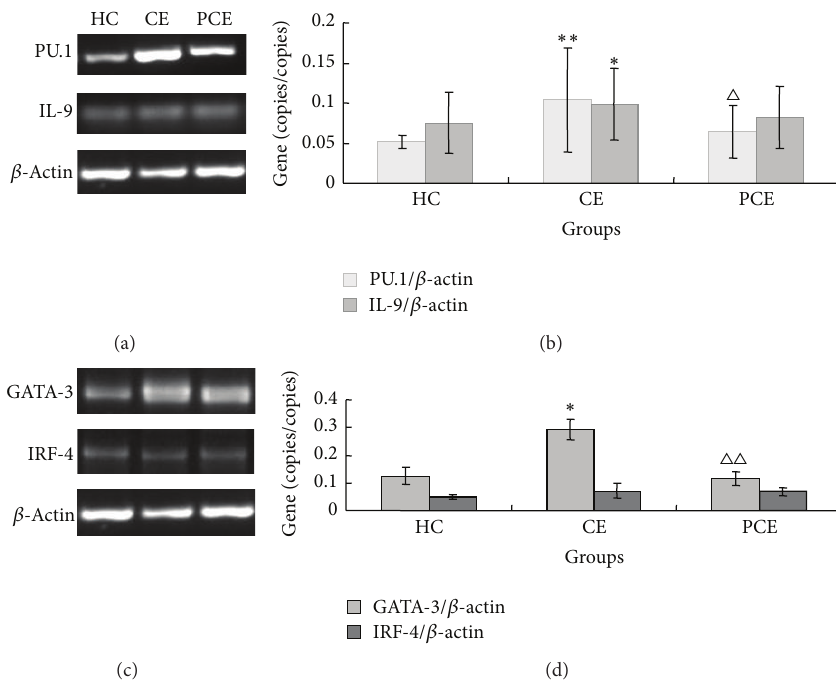
Figure 1: Quantitative RT-PCR. Total RNAs were extracted and subjected to reverse transcription, followed by determination by quantitative RT-PCR. The 2 −ΔΔ Ct method was used to determine the cycle number Ct value corresponding to a specific fluorescence threshold and quantify the target genes. 𝛽 -Actin was used as an internal control. (a) The PU.1 and IL-9 mRNA expression in HC, CE, and PCE groups. (b) Relative expression values of PU.1 and IL-9 mRNA were calculated based on the values of 𝛽 -actin. (c) The GATA-3 and IRF-4 mRNA expression in HC, CE, and PCE groups. (d) Relative expression values of GATA-3 and IRF-4 mRNA were calculated based on the values of 𝛽 -actin. ∗ 𝑃 < 0.05 ; ∗∗ 𝑃 < 0.01 , compared with the HC group. △ 𝑃 < 0.05 ; △△ 𝑃 < 0.01 , compared with CE group. HC: healthy control; CE: CE pretherapy group; PCE: CE posttherapy